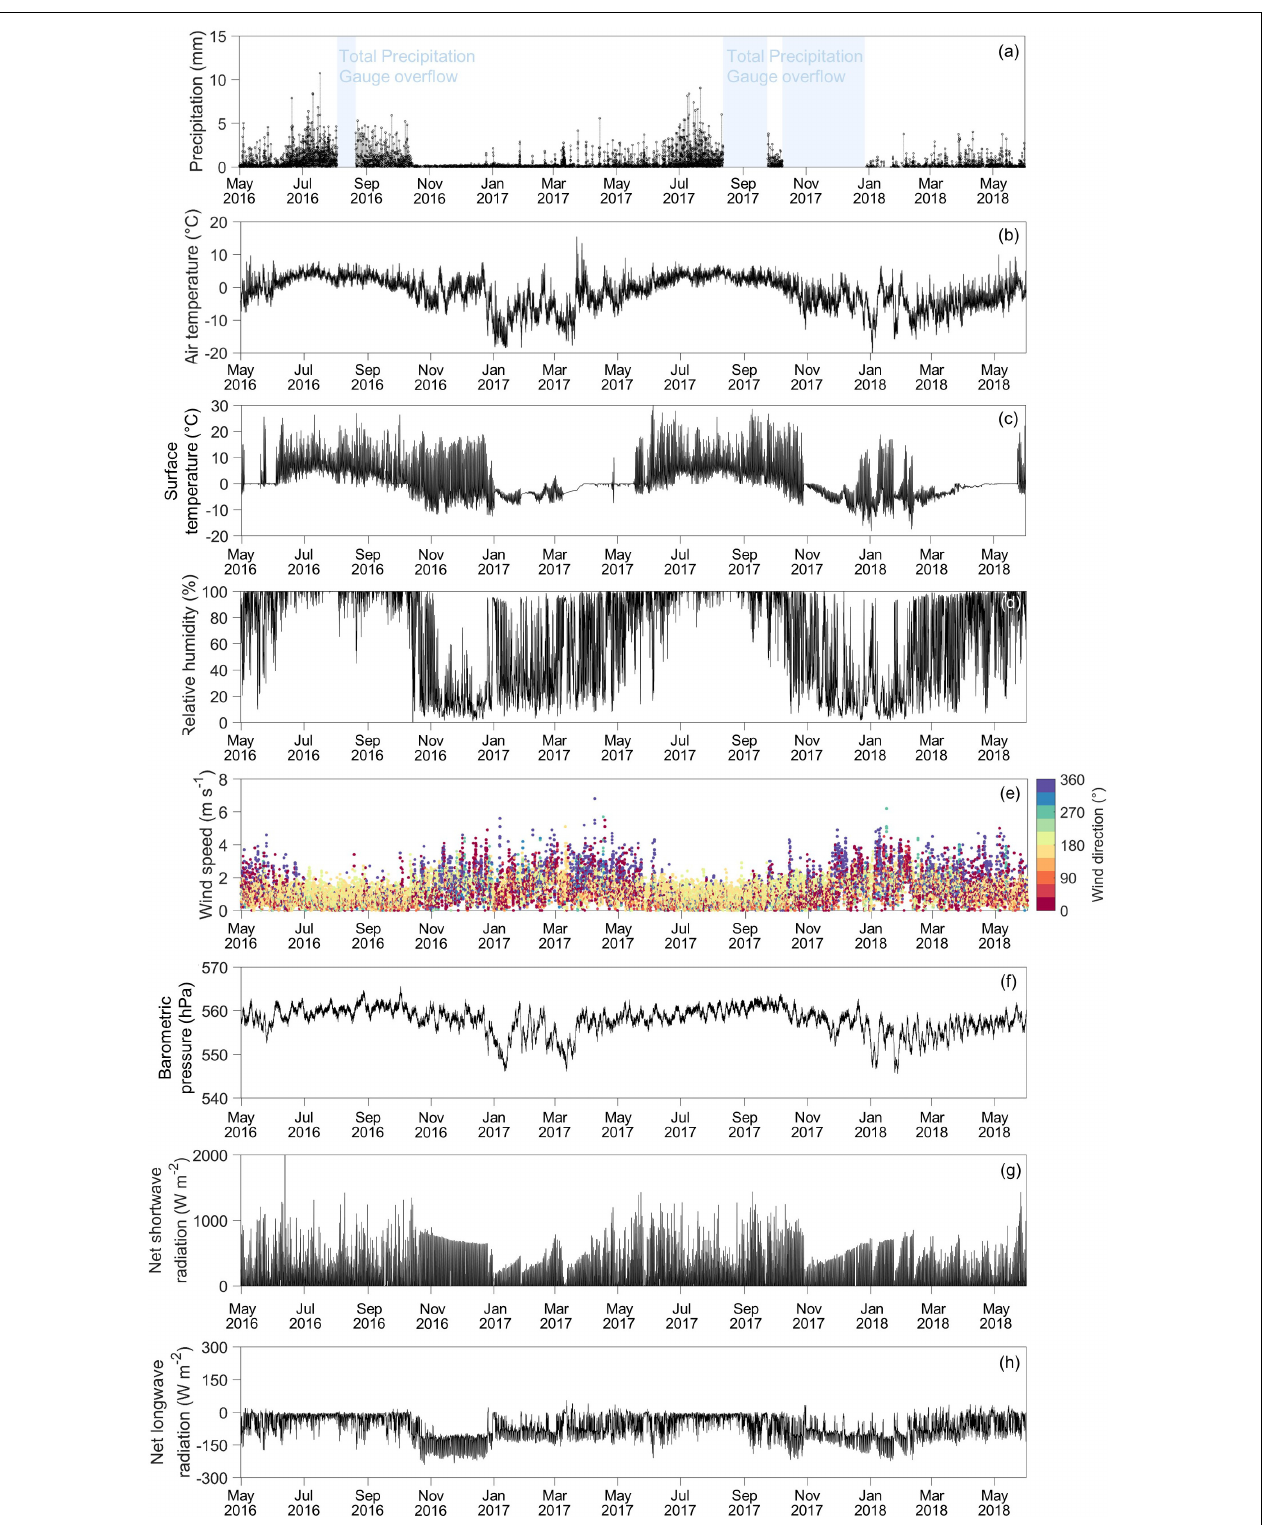
FIGURE 3 | Hourly meteorological data measured by the automatic weather station between May 2016 and June 2018. (a) Precipitation from the Total Precipitation Gauge, (b) air temperature, (c) surface temperature, (d) relative humidity, (e) wind speed and direction, (f) barometric pressure, (g) net shortwave radiation and (h) net longwave